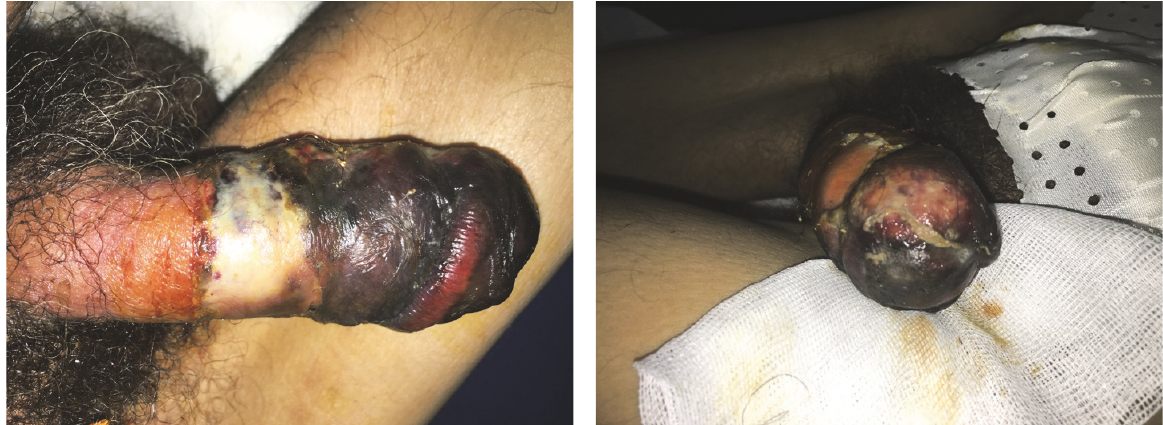
Figure 1: Penile aspect at the admission after removing the condom